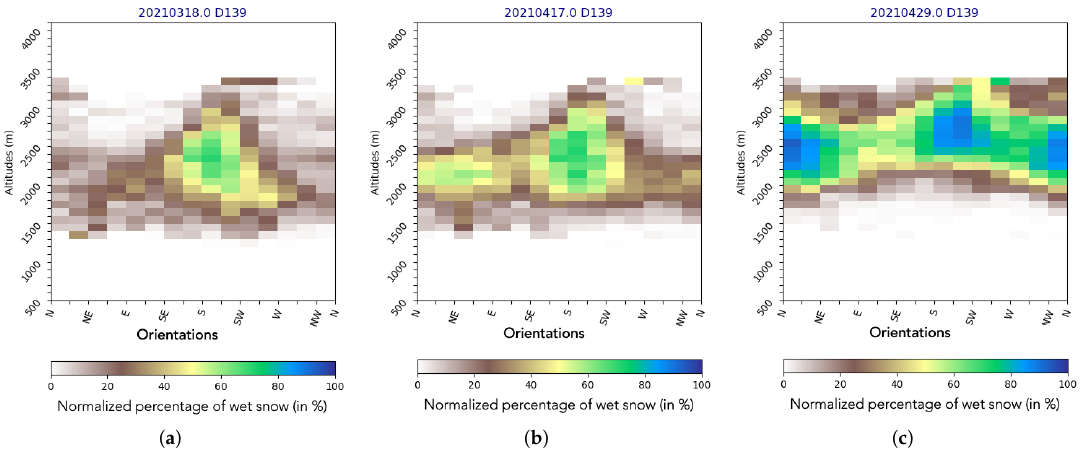
Figure 13. Same as Figure 9 but for spring 2021: ( a ) 18 March 2021 ( b ) 17 April 2021 and ( c ) 29 April